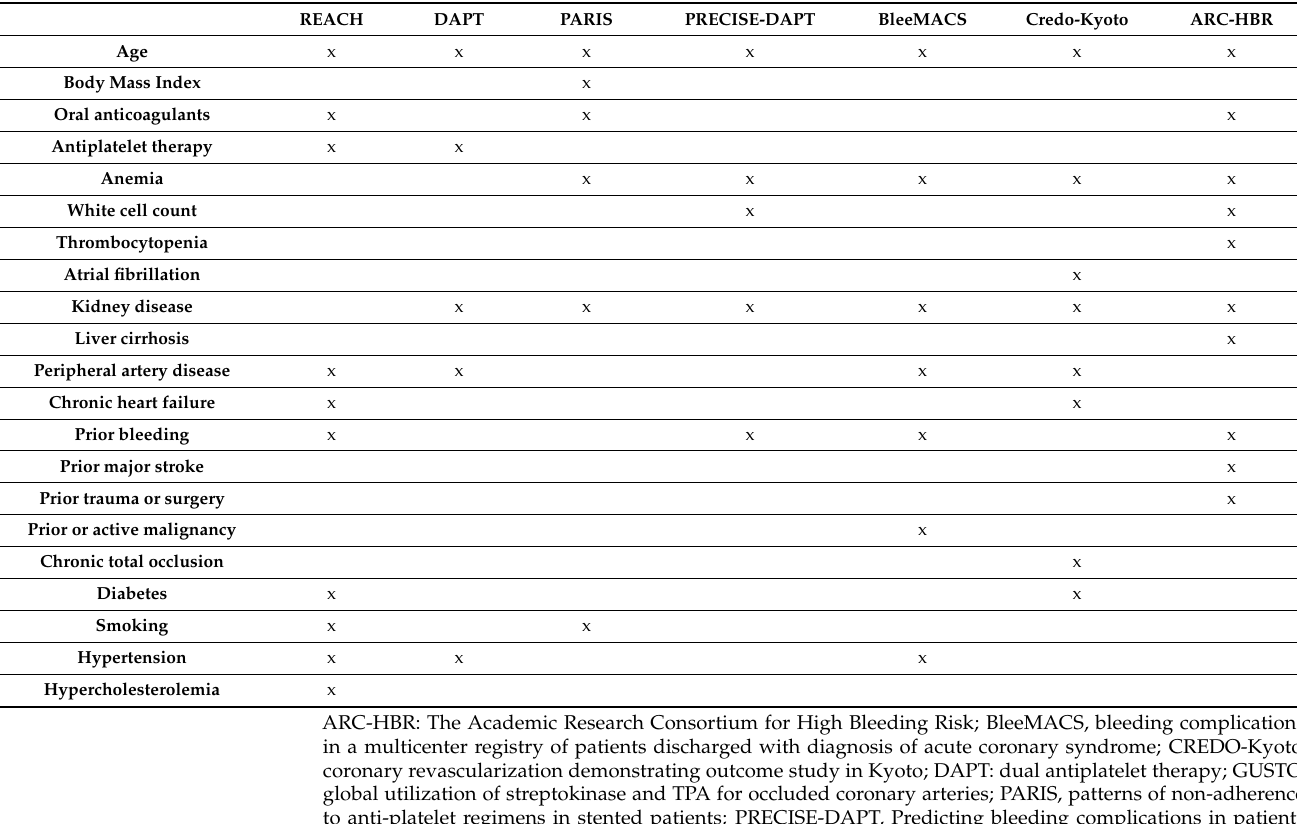
Table 2. Variables included in scores developed and validated to assess long-term bleeding risk in patients taking dual antiplatelet therapy after percutaneous coronary